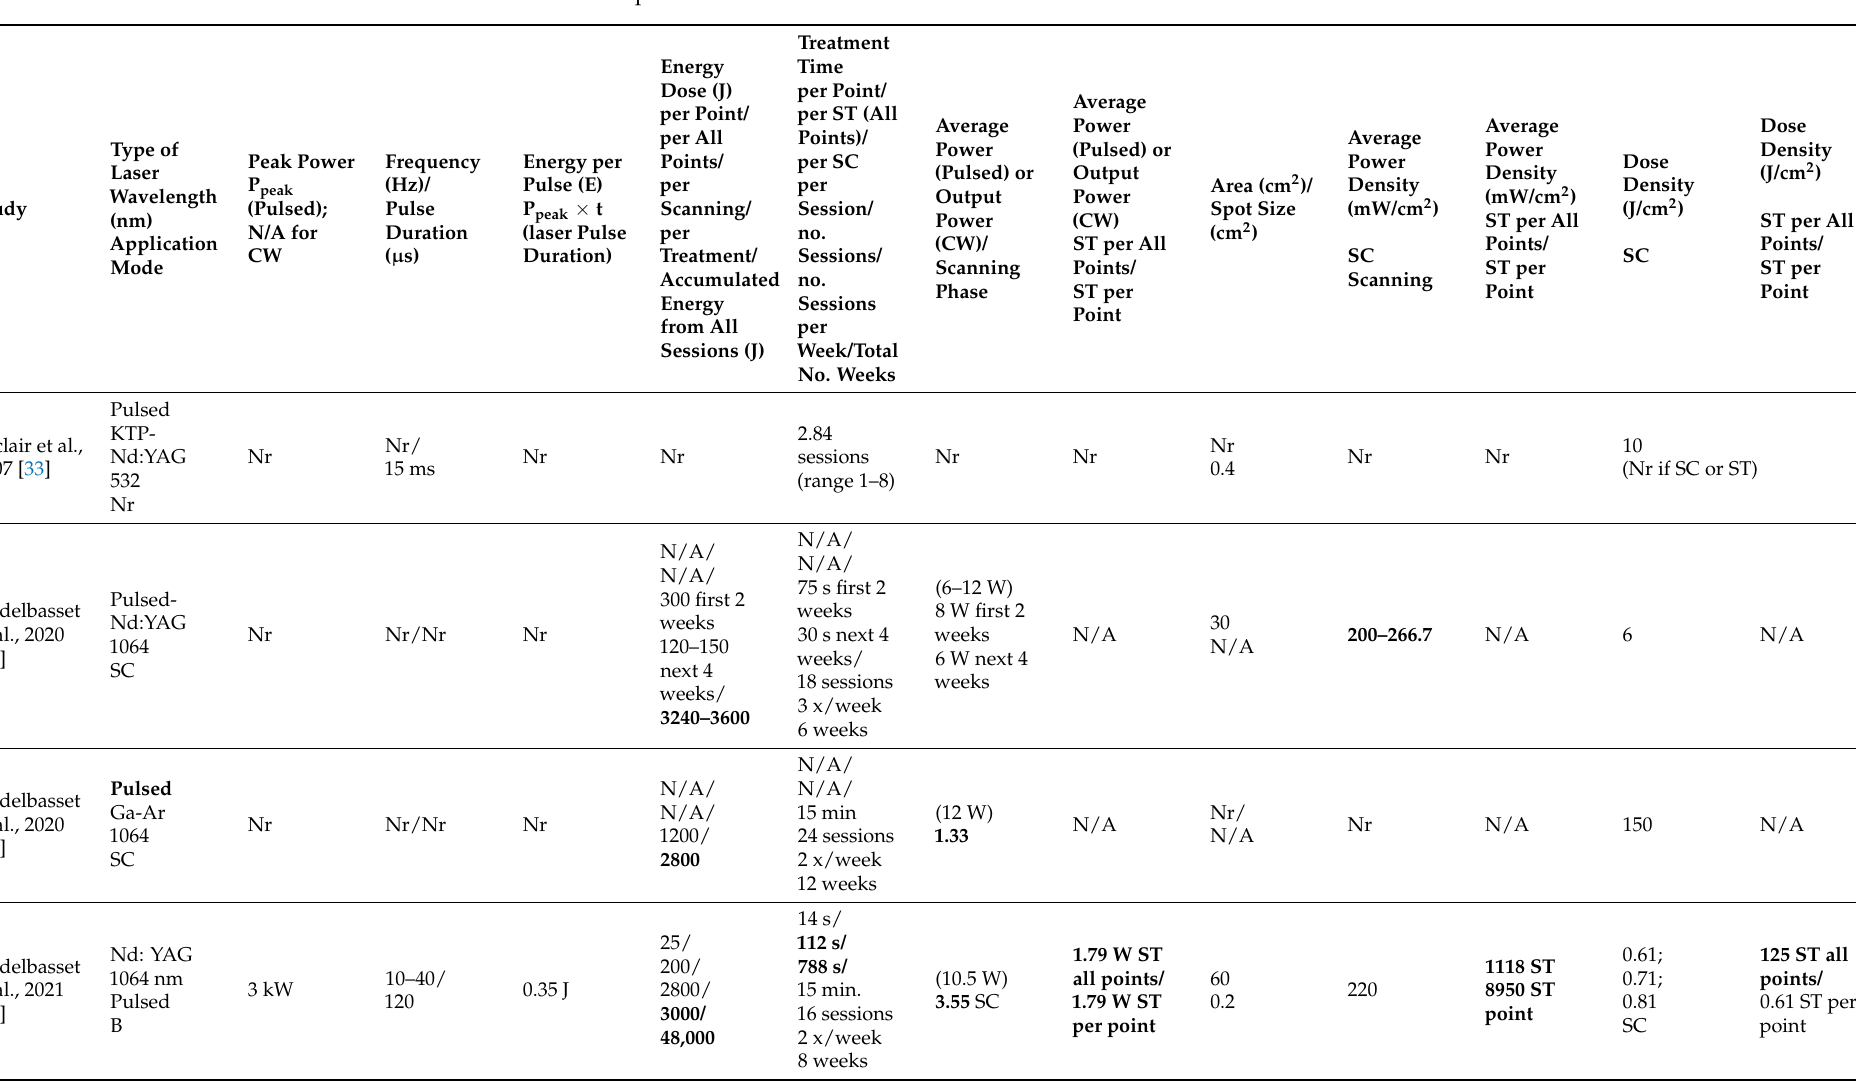
Table 3. Characteristics of the laser parameters in included